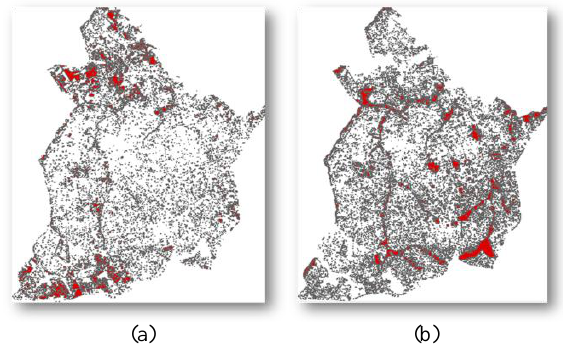
Figure 11 – vegetation change map: (a) Significant Change (SC), and (b) Small Change (LC).